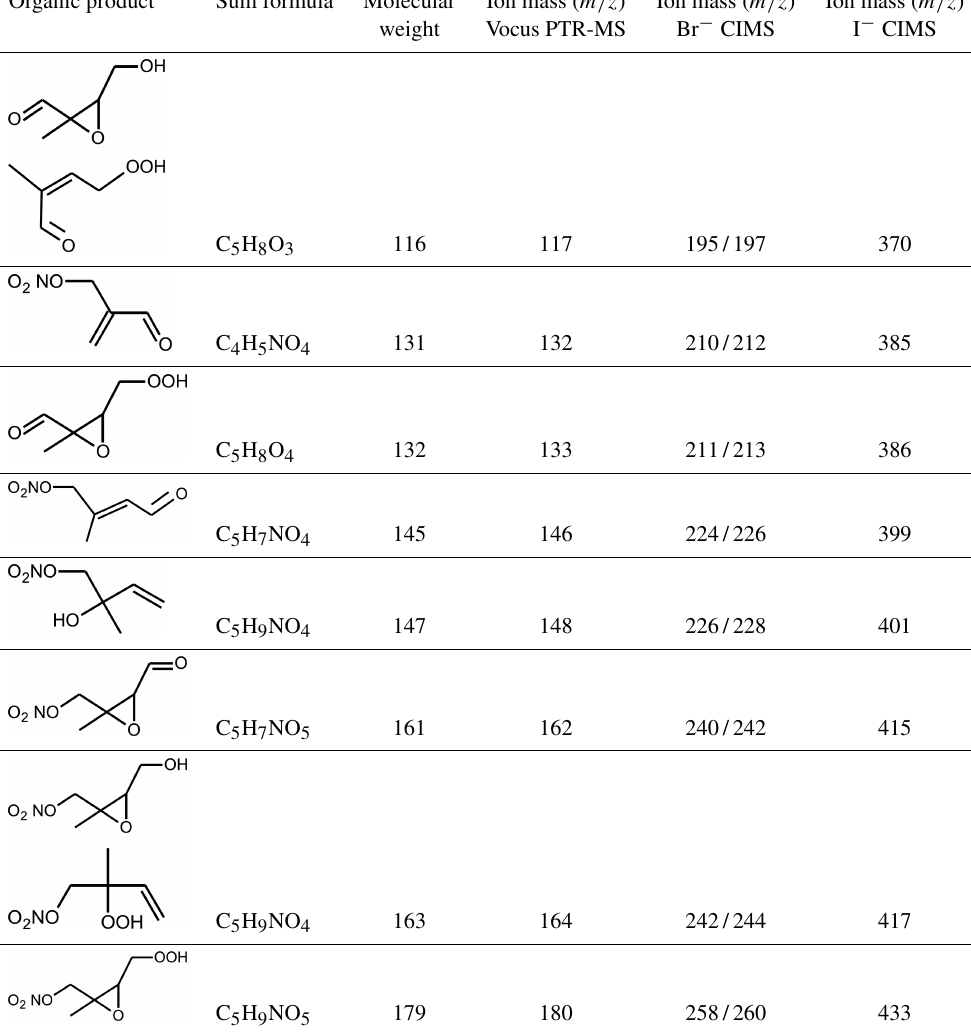
Table A1. Organic products expected to be produced from the oxidation of isoprene in this work and the ion mass ( m/z ) at which they are detected by the mass spectrometry instruments which undertook measurements in the experiments. Evaluation of the ion mass signals of the Br − CIMS instrument includes both major isotopes of Br (separated by a slash). Only the chemical structure of one isomer of the same compound is